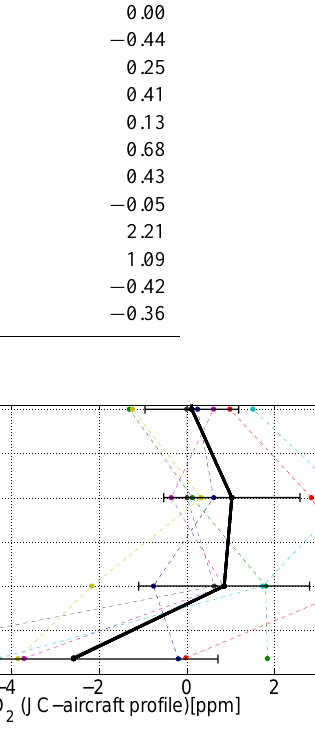
Fig. 12. Difference between the model profiles and contemporary low aircraft profiles on the common pressure-grid used for the inte- gration in Sect. 4.1. For the analyzed time period overall 12 low air- craft profiles up to 2.8km were conducted, of which 7 profiles were done within 2.15h of an available model output. The mean of the differences is given with a black line. At the ground the Jena CO 2 inversion underestimates the CO 2 concentration on average (by up to 2.5ppm) and overestimates it in 1 and 2km (by up to 1ppm). To compare the total column averages directly, the aircraft profiles were extended above the aircraft ceiling by attach- ing the most contemporary model profile to the highest air- craft measurement. Afterwards, the extended profiles were integrated as described in Sect. 4.1. The differences between the integrated extended low aircraft profiles and the inte- grated most contemporary model profiles are listed in Ta- ble 2. In Fig. 13, the scatter of the CO 2 total column aver- ages calculated with the extended aircraft profiles is shown in comparison to the original model data. Using the low air- craft profile measurements leads to a slightly better estima- tion of the X CO (correlation coefficient of 0.996). Calcu- 2 lated only for the overpass days, it reduces the difference of 1.06 ppm ± 0.35 ppm between the Jena CO 2 inversion and the FTS data to 1.00 ppm ± 0.26